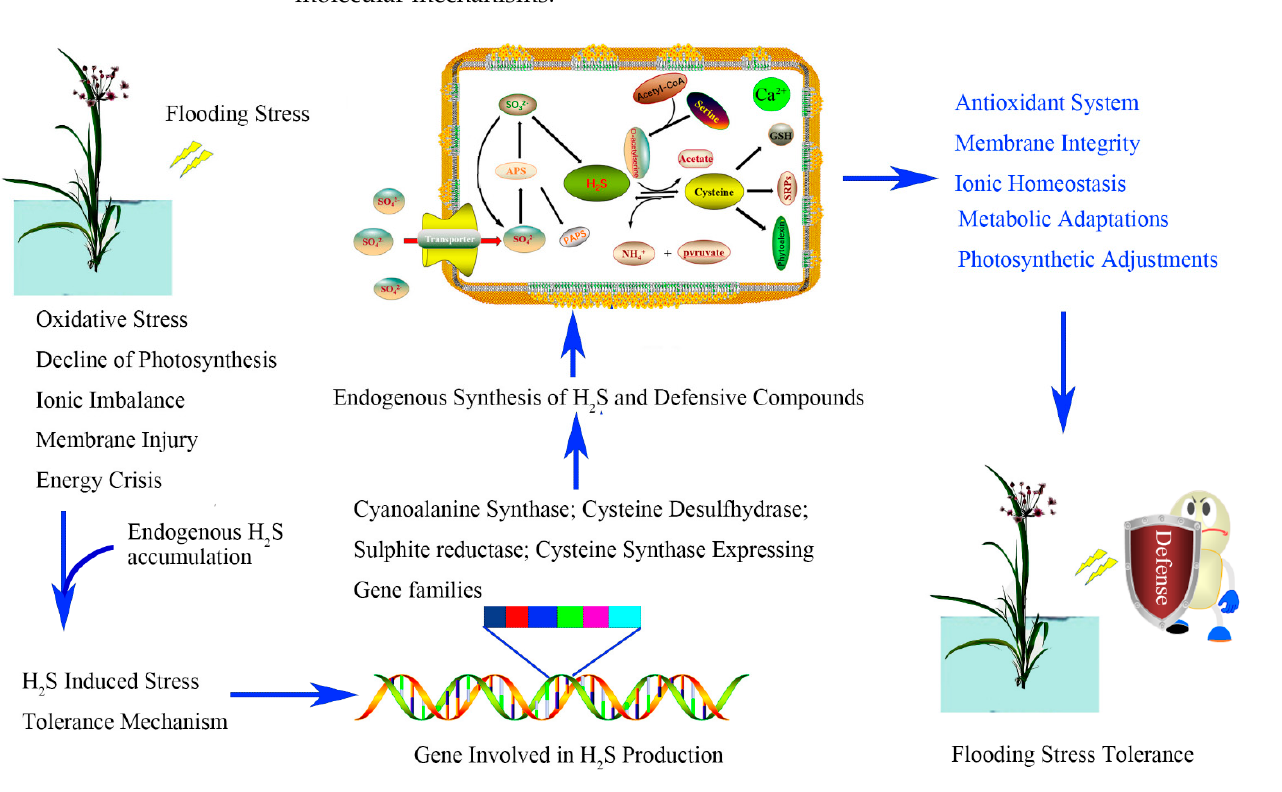
Figure 4. The role of H 2 S in the regulation of waterlogging stress in plants. In spite of these advances in the exploration of H 2 S's response mechanism to hypoxia, many challenges remain. Firstly, the direct target, upstream and downstream cascade reaction of H 2 S in the plant signal transduction process, and the crosstalk among H 2 S and other signal molecules should be further elucidated. On the other hand, the process of plant response to hypoxia stress depends on the proportion of different hormones, of which H 2 S may be the intermediate to coordinate the interaction, while whose mechanism is still not clear yet. However, with the continuous development of transgenic technology and gene-editing technology, we believe the molecular mechanism of H 2 S involved in the regulation of hypoxia response is becoming increasingly clear.